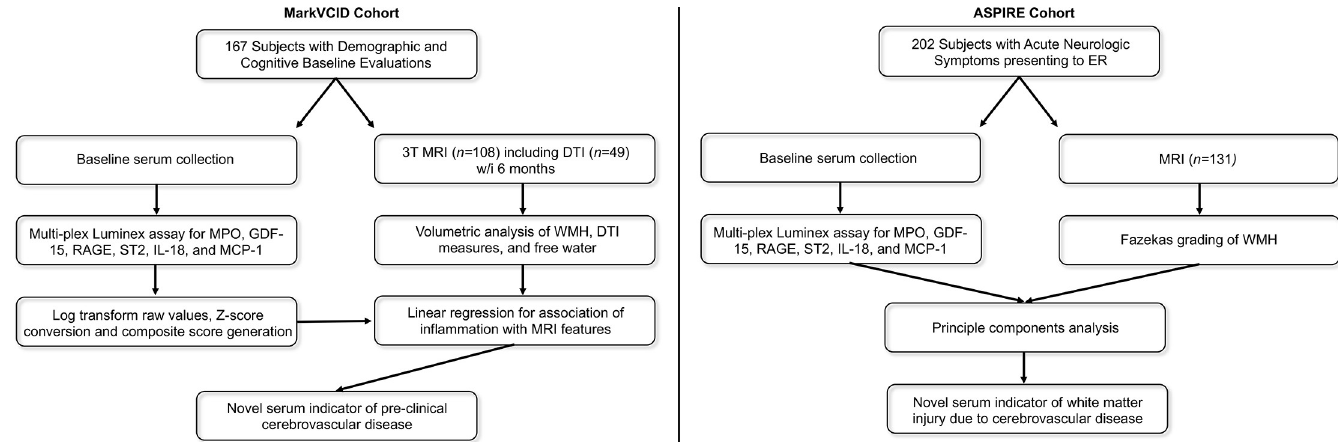
Fig 1. Imaging and fluid analysis workflows in the MarkVCID and ASPIRE cohorts. Workflow diagram of the MarkVCID cohort of 167 subjects that underwent detailed cognitive evaluations, MRI including DTI, and serum collections (left). Workflow diagram of the ASPIRE cohort of 202 subjects presenting with acute neurologic symptoms who underwent MRI and concurrent serum collection